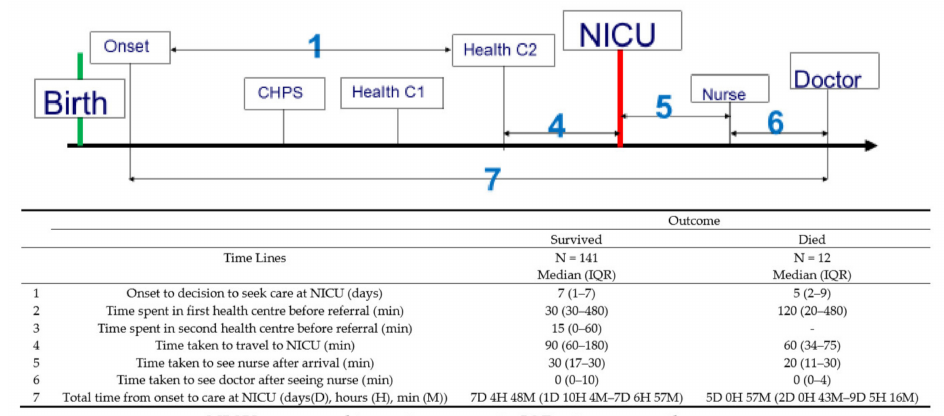
Figure 2. Timeline analysis of referral pathway of outborn neonates referred to the neonatal unit.